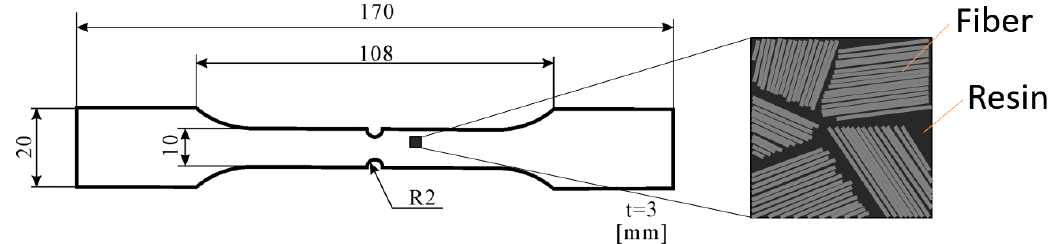
Figure 2. Configurations of employed short carbon fiber reinforced plastic specimen.